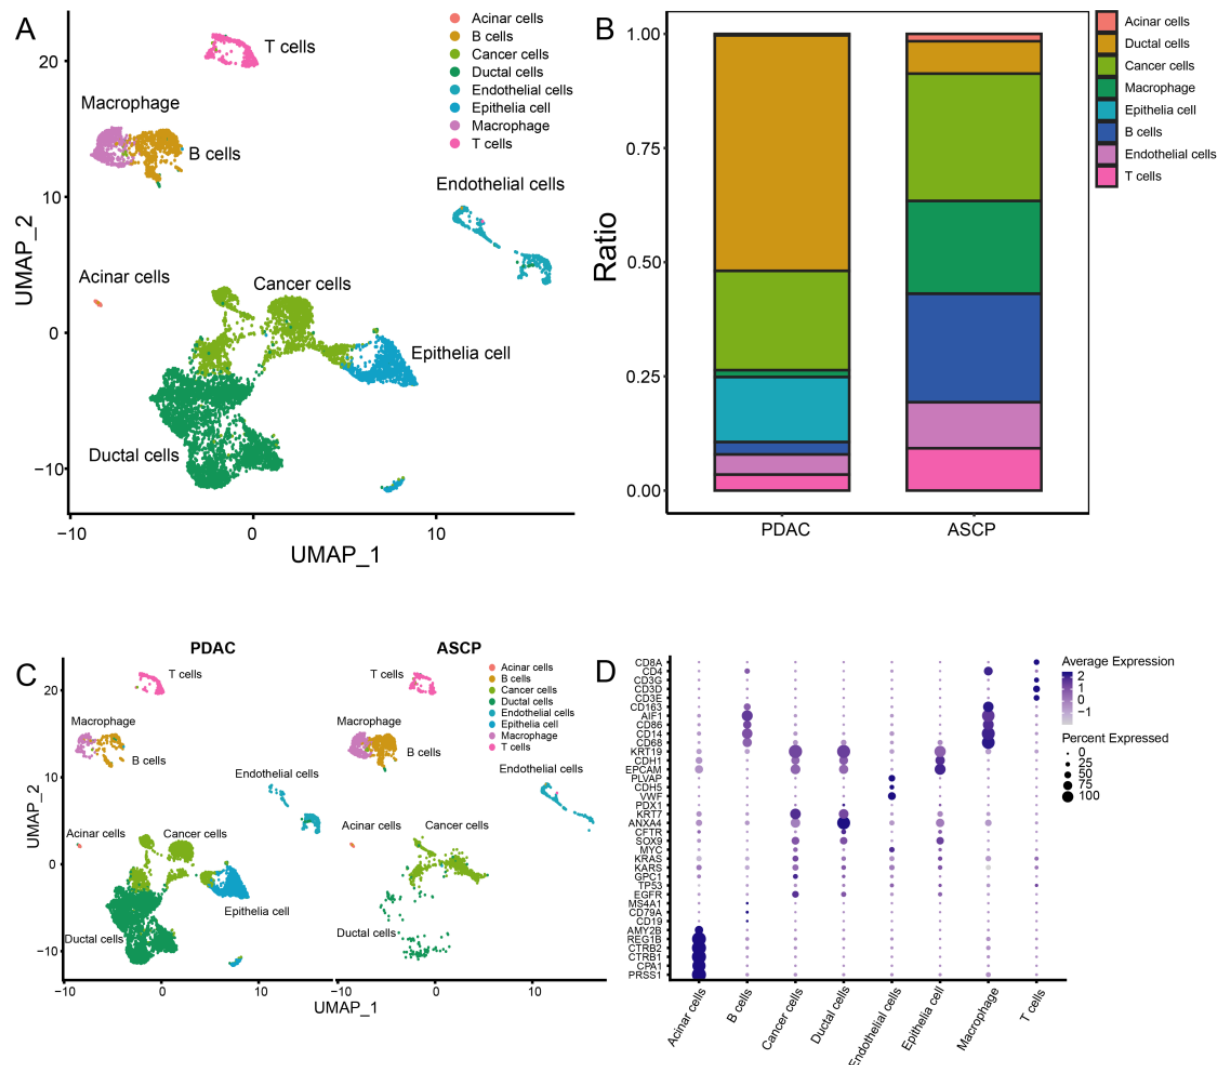
Figure 3. A total of 8327 single cells were clustered into ten subgroups based on scRNA-seq. ( A ) UMAP plot showing eight cell types in tissues of the PC. ( B ) Percentage of cell types between PDAC and ASCP. ( C ) Cell distribution in the PDAC and ASCP. ( D ) Annotation of each subgroup with markers.